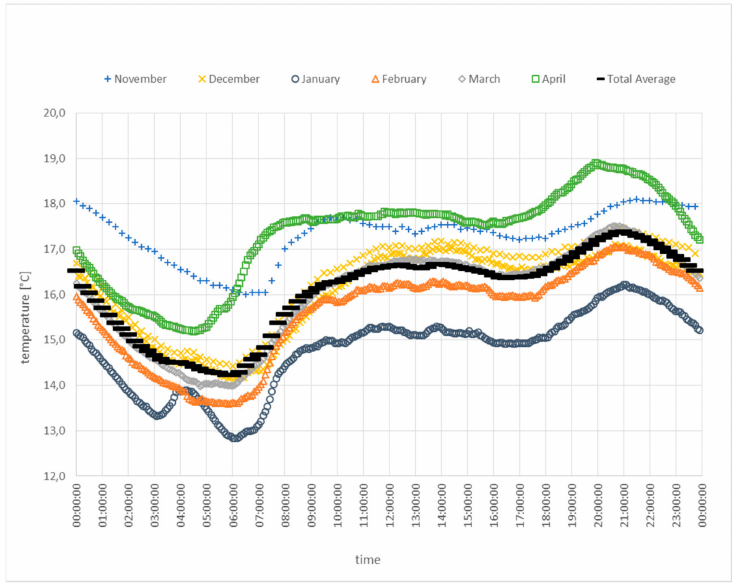
Figure 5. Monthly and total average dry weather wastewater temperature from November 2015 to April